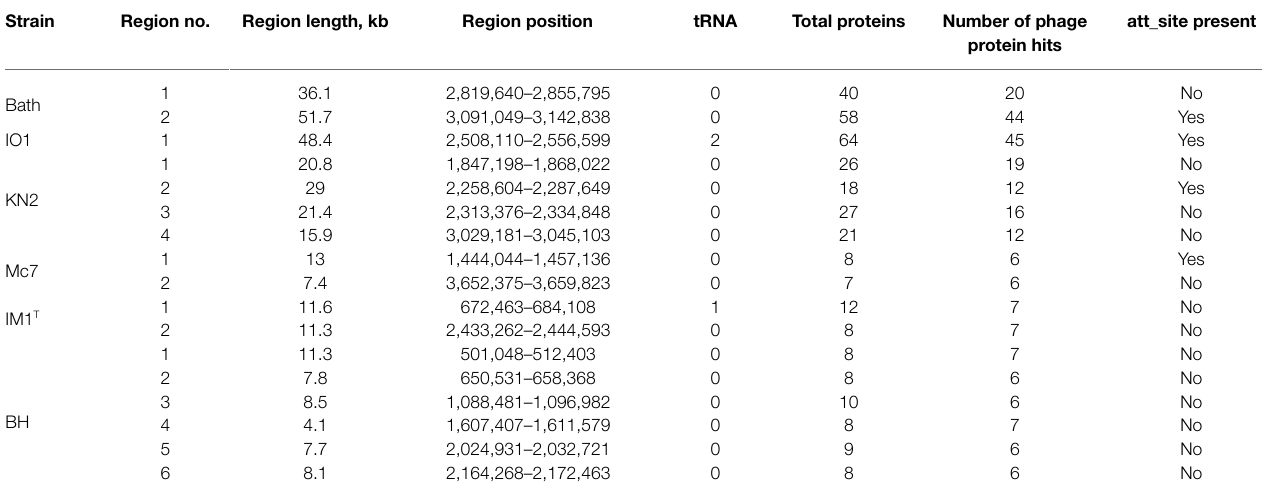
TABLE 3 | Prophage regions revealed in the examined Methylococcus genomes. Strain Region no. Region length, kb Region position